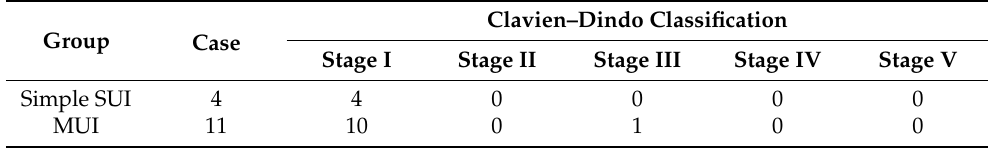
Table 6. Clavien–Dindo classification of postoperative complications in patients with simple SUI and MUI. Clavien–Dindo Group Case